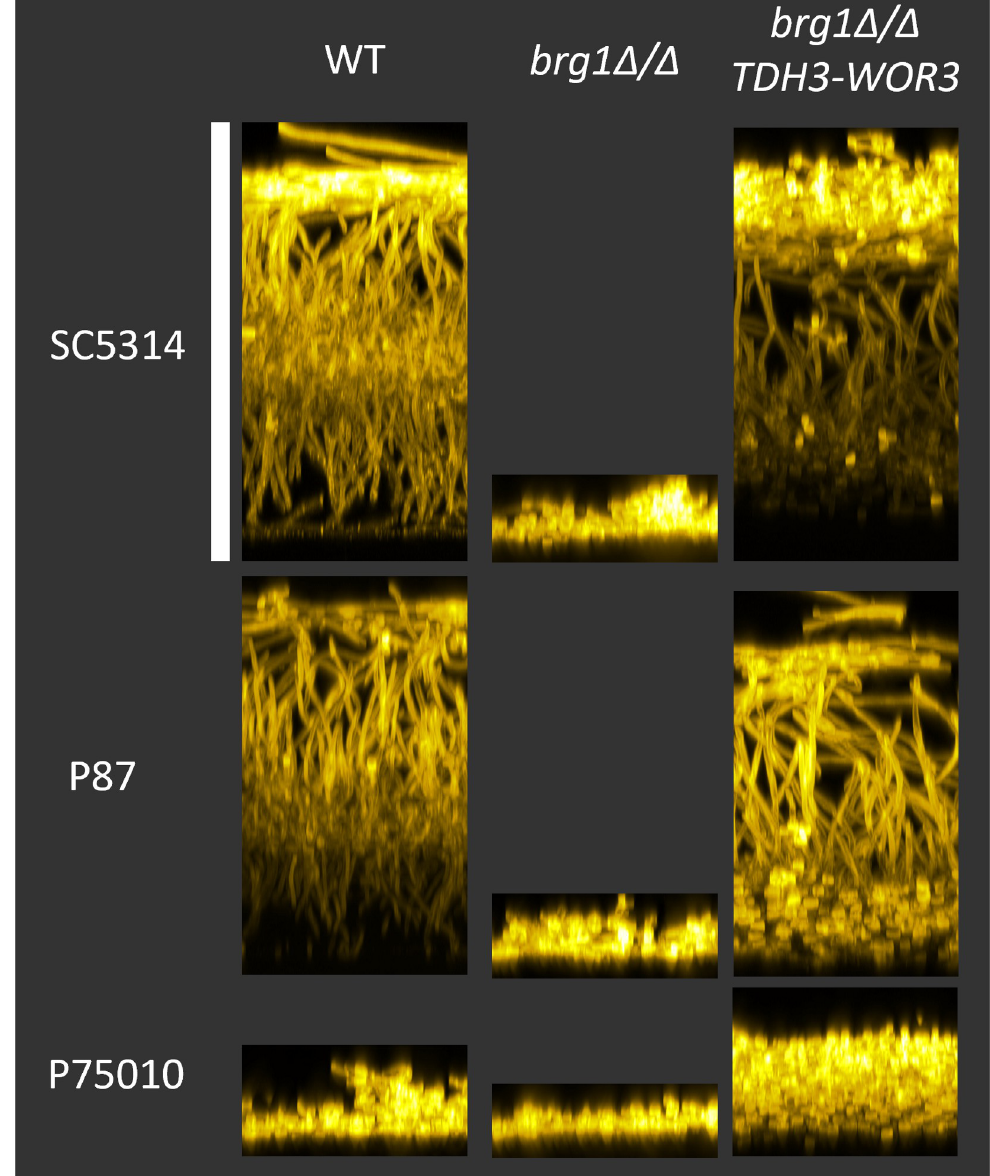
Fig 9. Biofilm formation in brg1 Δ / Δ and brg1 Δ / Δ TDH3-WOR3 strains. Wild-type (WT), brg1 Δ / Δ , and brg1 Δ / Δ TDH3-WOR3 strains in the indicated clinical isolate backgrounds were assayed for biofilm formation in RPMI+FBS, 37˚C for 24hrs using the “Silicone substrate–confocal microscopy” method. Biofilm sideview images are above. Scale bar indicates 145 μ